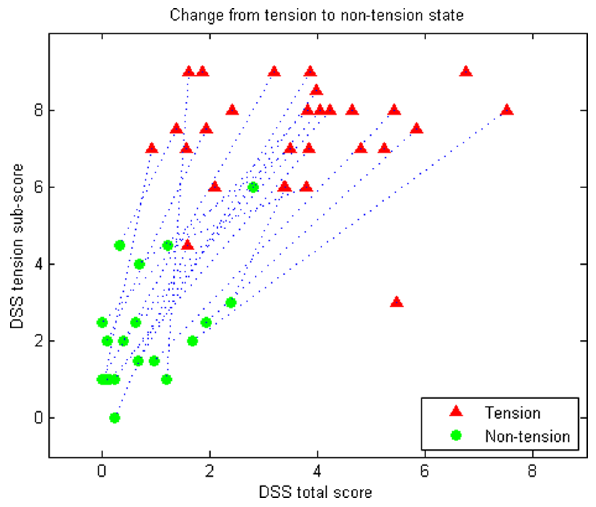
Figure 1. DSS total scores and tension sub-scores for tension and non-tension state. Scores are averages over the two observa- tions in each state. The dashed line represents the patients and the two states of each